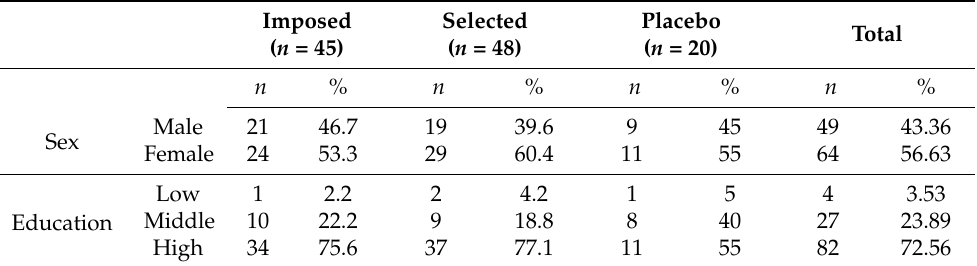
Table 1. Demographic variables.